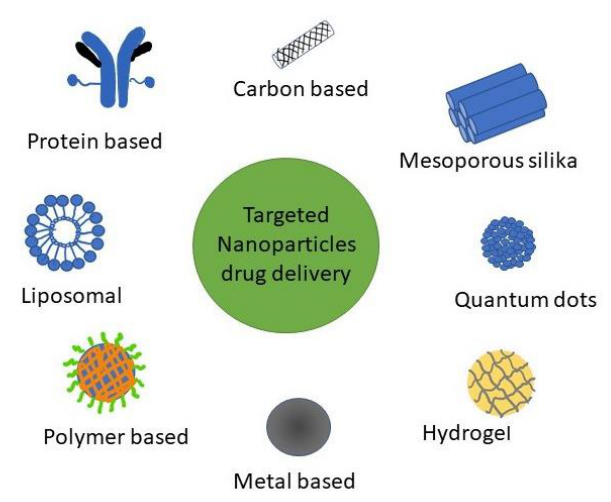
Figure 1. Types of NPs for targeted DDS used in BC research.